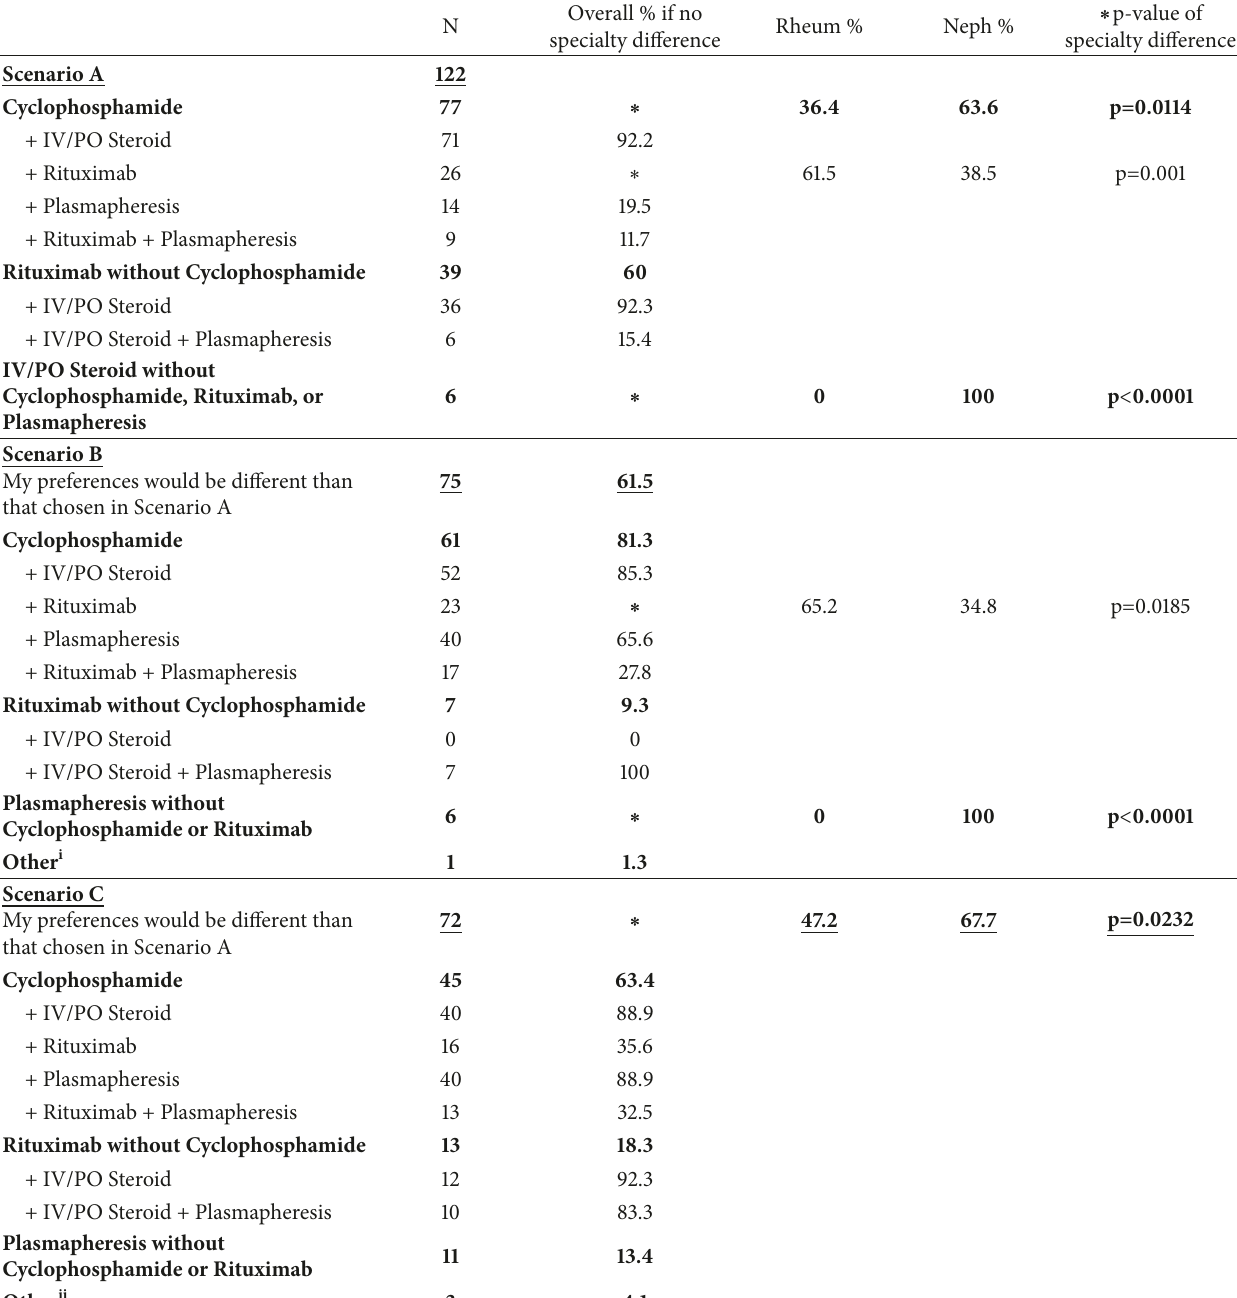
Table 2: Characteristics of combination answer selections for Scenarios